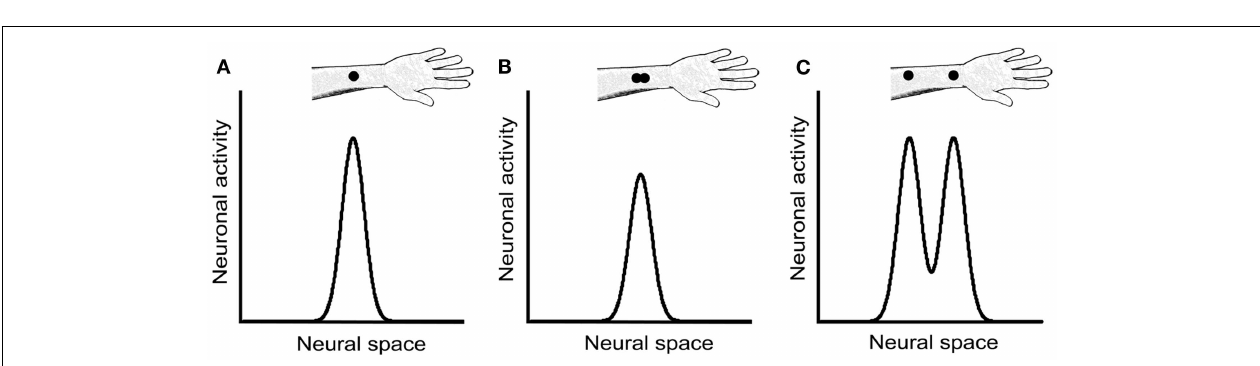
another, because both configurations result in a single peak of neural activity. However, the neurophysiological data (Vega-Bermudez and Johnson, 1999) suggest that the population response in (B) is of lower magnitude than in (A) , a cue that allows the participant to distinguish (A) from (B) by non-spatial means. In (C) , the two activity peaks are indeed distinguishable spatially; in addition, because each activity peak in (C) has equal height to the single peak in (A) , the total population response in (C) is greater that in (A) , giving rise to another magnitude